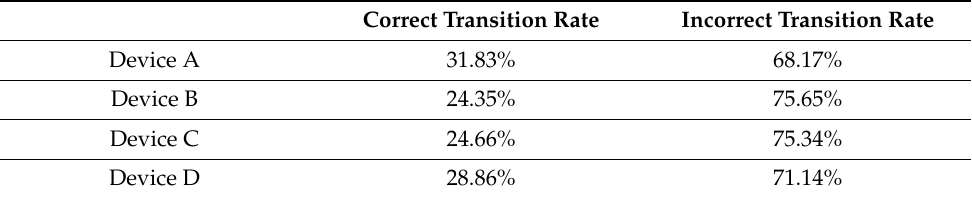
Figure 5. Reported results for the correct and incorrect sleep and wake stage transition in 30 datasets collected by Device A. Table 7. Correct and incorrect sleep stage transition rates among the four wearable